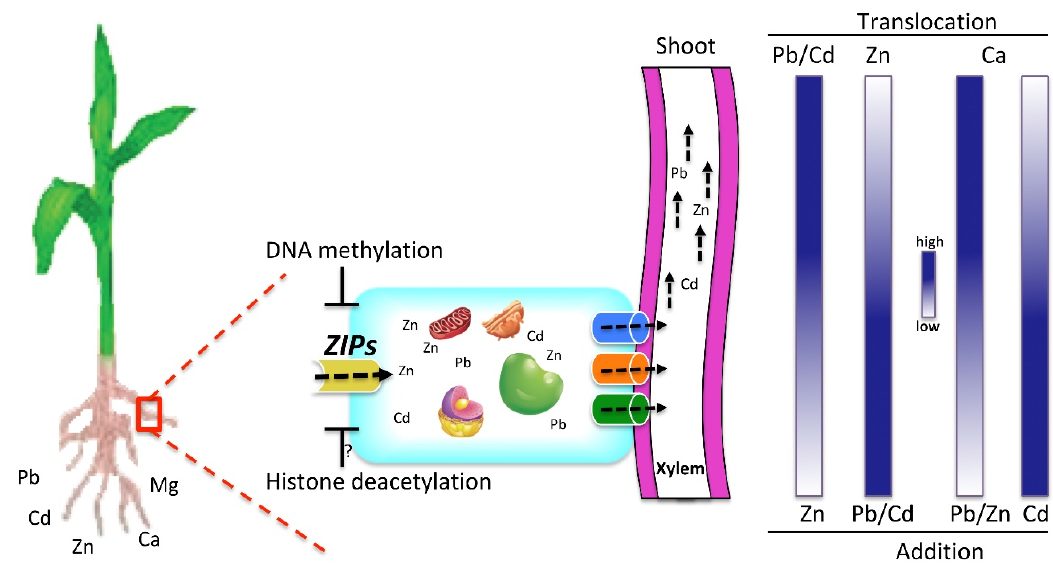
Figure 8. Proposed model for the uptake and translocation interplay of Pb, Cd, and Zn through ZIP